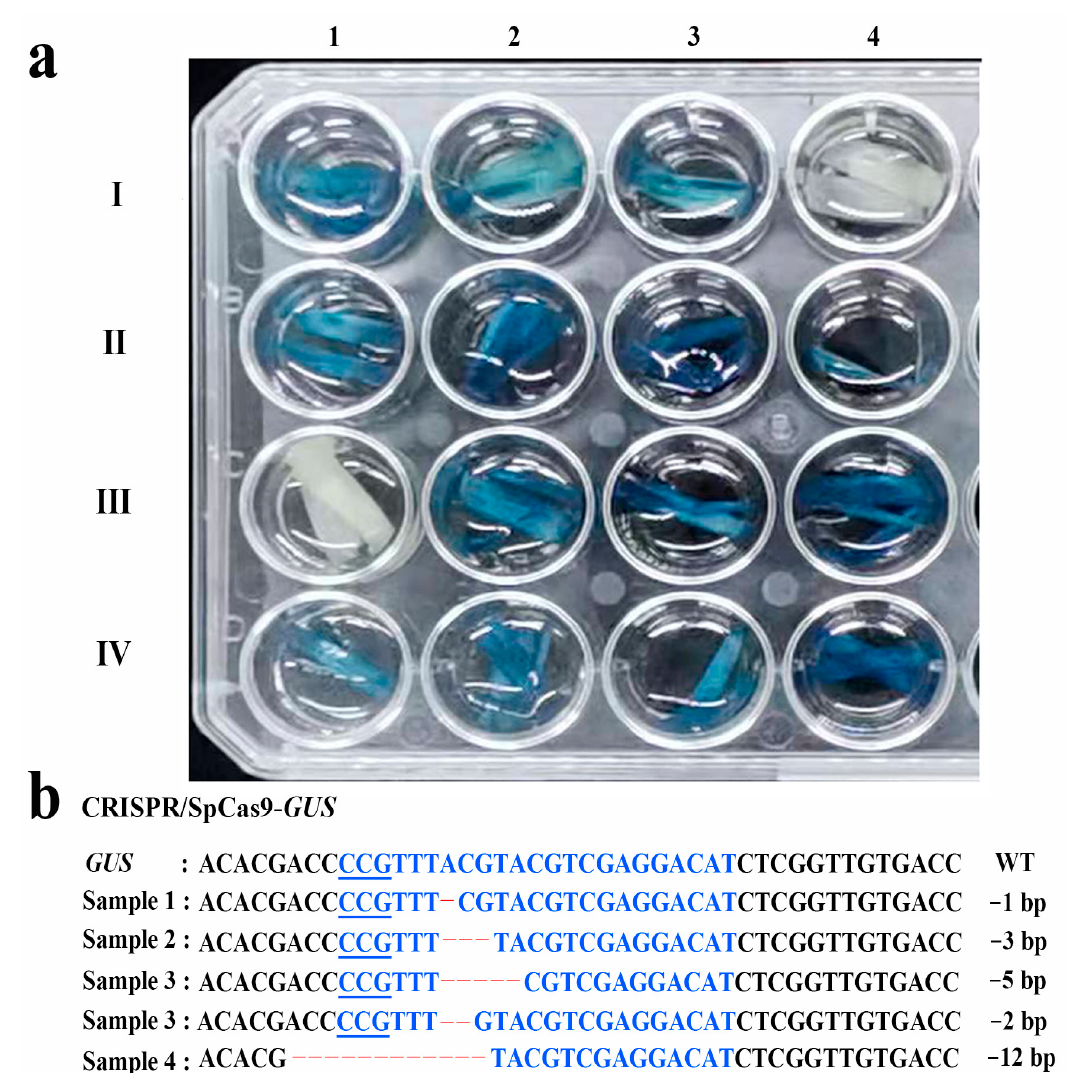
Figure 1. GUS staining and sequence analysis in the new mutant wheat plants. ( a ) The expression of GUS protein in mutants. I1-I3: the mutants from groups 7-2.5-G. I4: non-transgenic variety CB037. II1-II4: the mutants from the groups 7-5-G. III1-III4: the mutants from the groups 14-2.5-G. IV1-IV3: the mutants from the groups 14-5-G. IV4: the transgenic line H29 with GUS gene. III1: plant with biallelic mutations (the other mutants are heterozygous mutations). ( b ) Deletion mutations in the GUS gene in the mutants. The PAM region is underlined; blue letters indicate sgRNA sequences, and dashed lines represent nucleotide deletions.